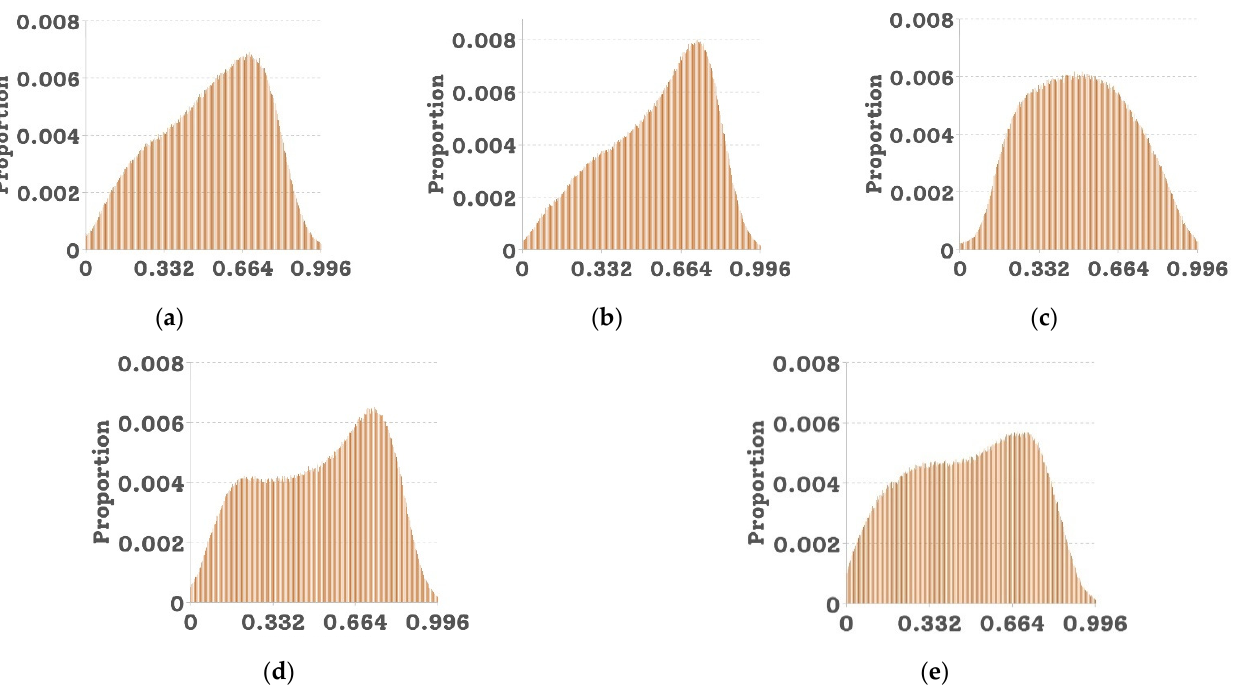
Figure 11. Vegetation coverage of forest in different years. ( a ) In 1990; ( b ) In 2000; ( c ) In 2005; ( d ) In 2010; ( e ) In 2020.